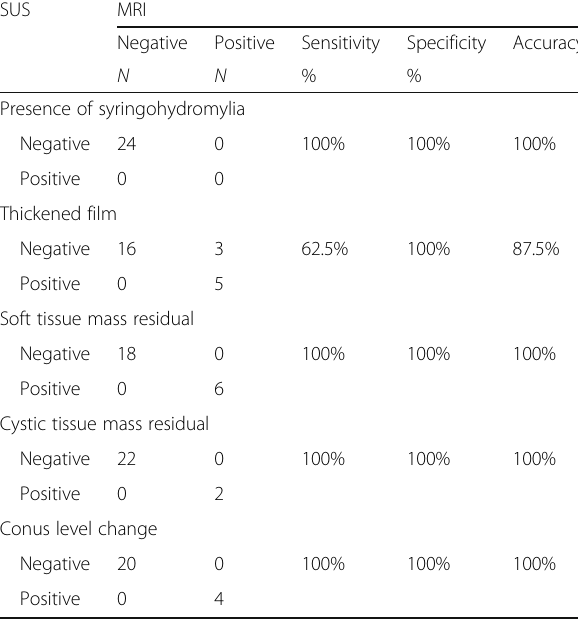
Table 3 Comparison between LUS and MRI imaging after